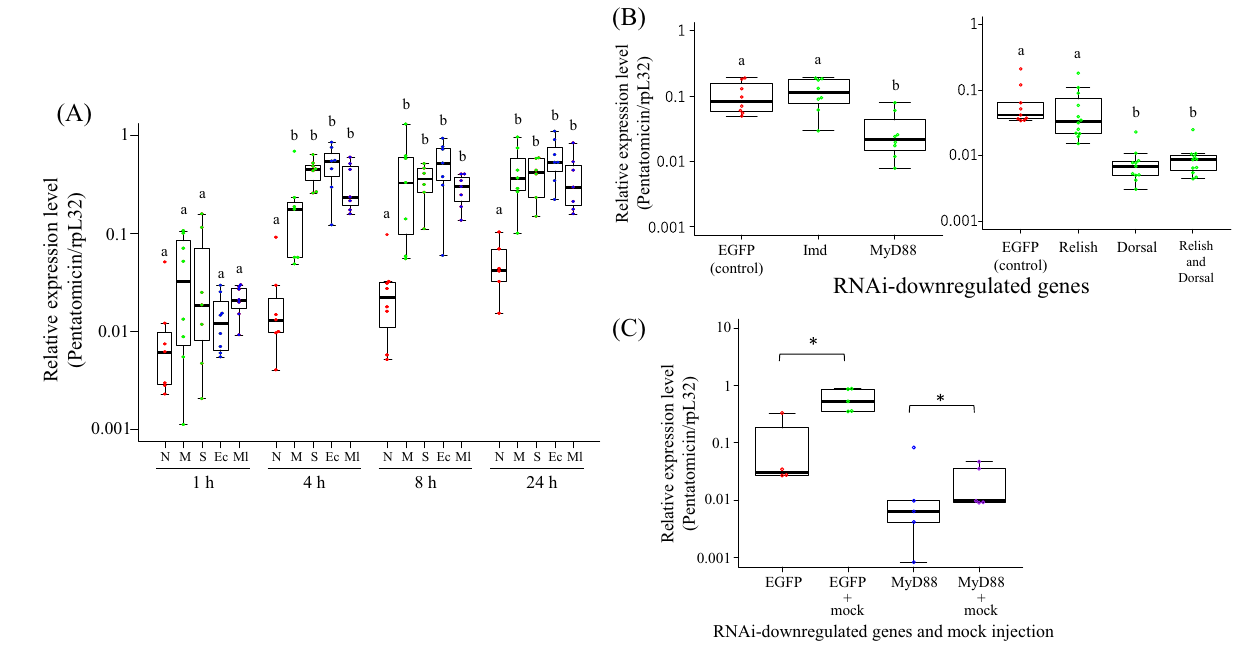
Figure 3. The expression patterns of Pentatomicin in adult fat bodies. ( A ) The effects of septic shock treatments on the expression levels of Pentatomicin . Adult females were subjected to the following treatments: N no treatment, M mock injection, S saline injection, Ec heat-killed E. coli injection, Ml heat-killed M. luteus injection. Quantitative RT-PCR was performed for the samples harvested 1, 4, 8, and 24 h after injection (n = 5–8). Different letters show statistically significant differences in each time point (Steel–Dwass test: P < 0.05). ( B ) Effects of RNAi knockdown of immune pathway genes on septic shock-induced upregulation of Pentatomicin . Adult insects were injected with heat-killed E. coli 3 days after dsRNA injection and subjected to RNA extraction on the following day (n = 9–12). Different letters show statistically significant differences (Steel– Dwass test: P < 0.05). ( C ) Effects of RNAi knockdown of immune pathway genes on mock injection-induced upregulation of Pentatomicin . Adult insects were injected with a clean needle 3 days after dsRNA injection and subjected to RNA extraction on the following day (n = 4–5). Statistical analysis was done by Mann–Whitney U test ( P <